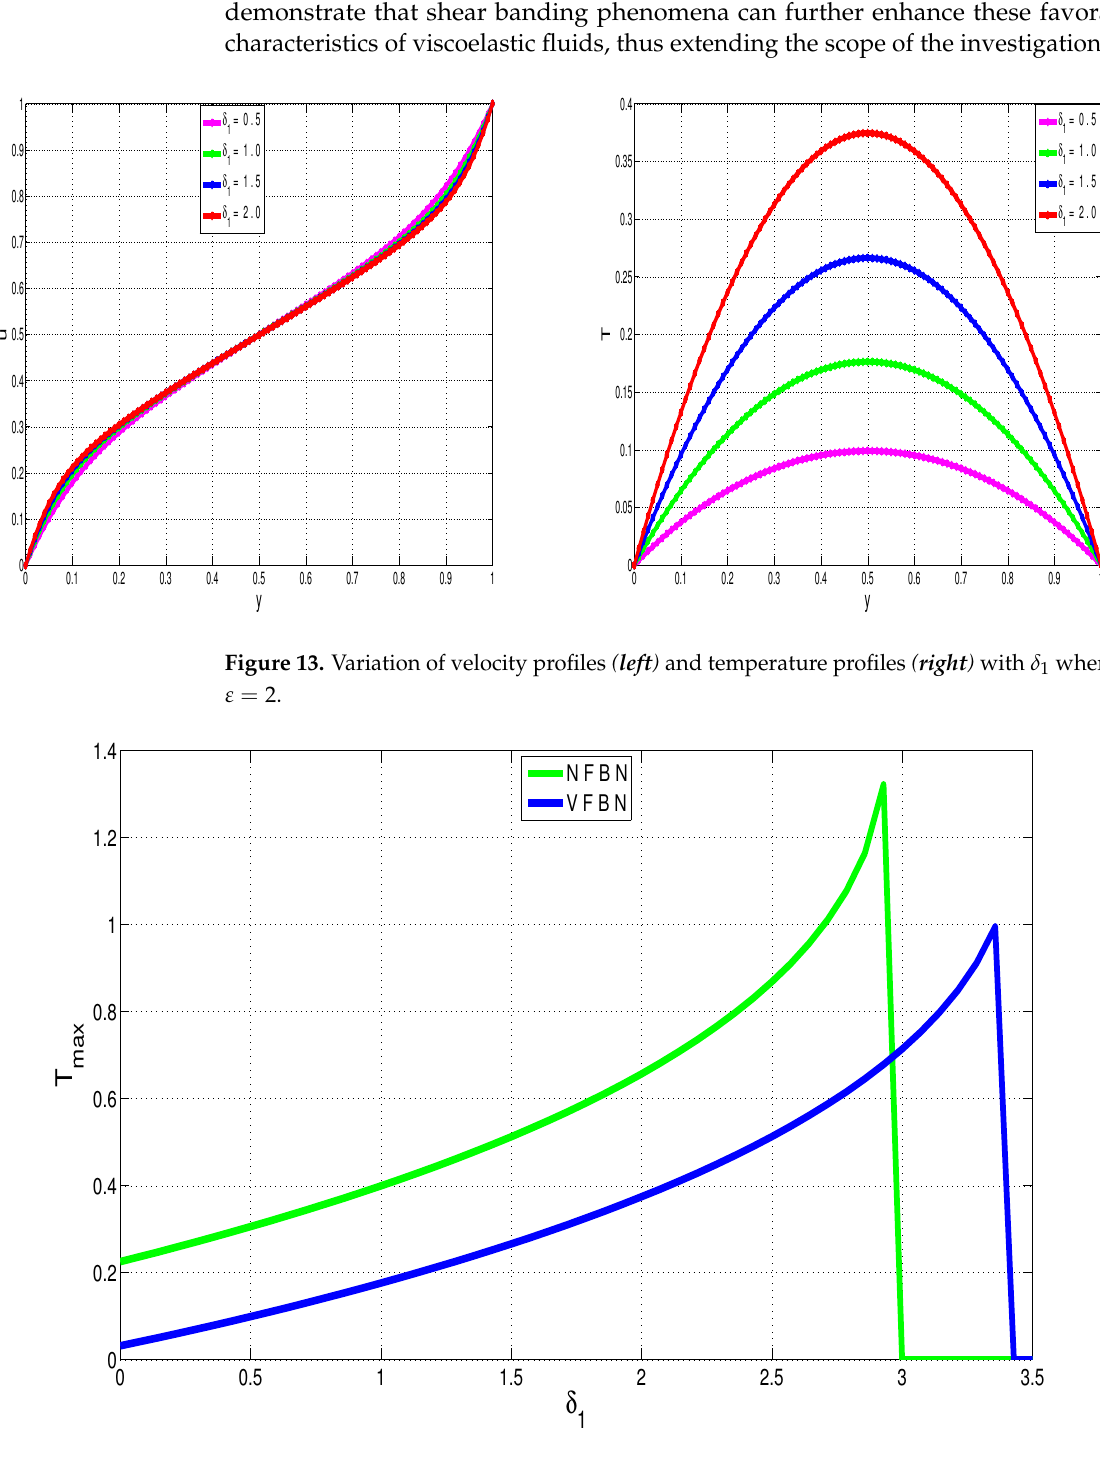
Figure 14. thermal runaway behavior for the NFBN and VFBN where β = 0.95, ε =